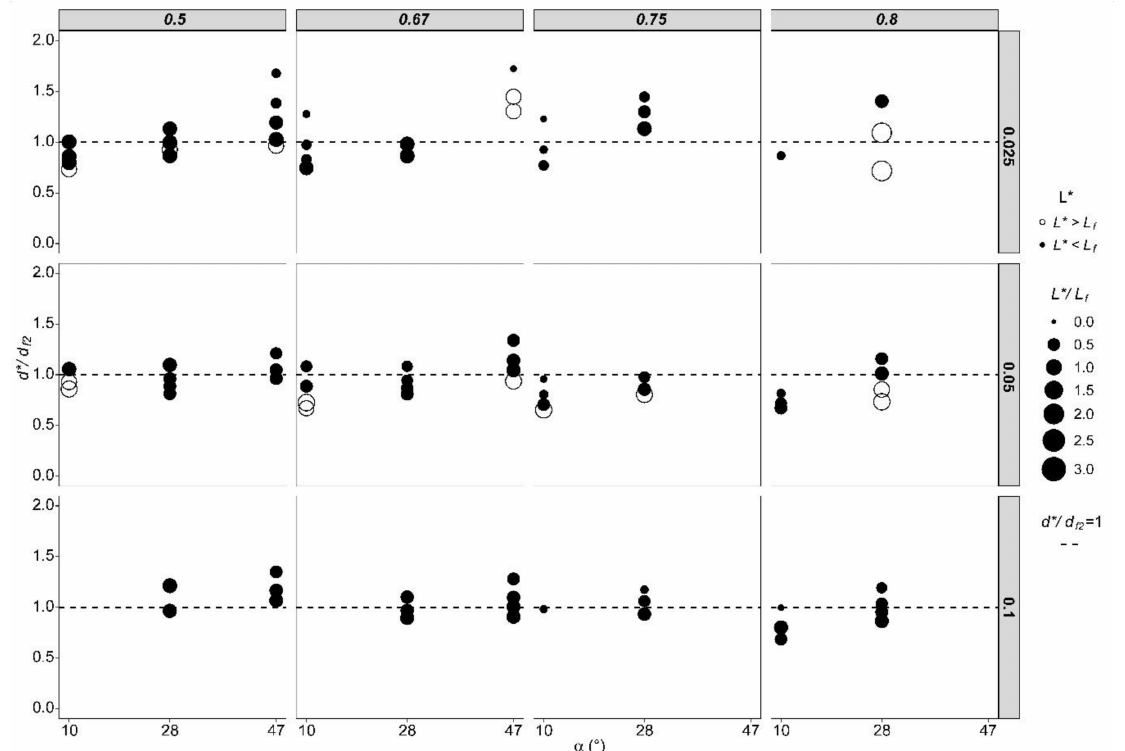
Figure 10. d* / d f2 ( − ) with respect to α ( ◦ ) for tests when P is zero. The figure is organized in a matrix layout, with vertical columns representing K Q ( − ) and horizontal rows representing Q T (m 3 s − 1 ). Filled circles represent cases where L * < L f ; empty circles represent L* > L f . The size of every circle represents L* / L f ( −